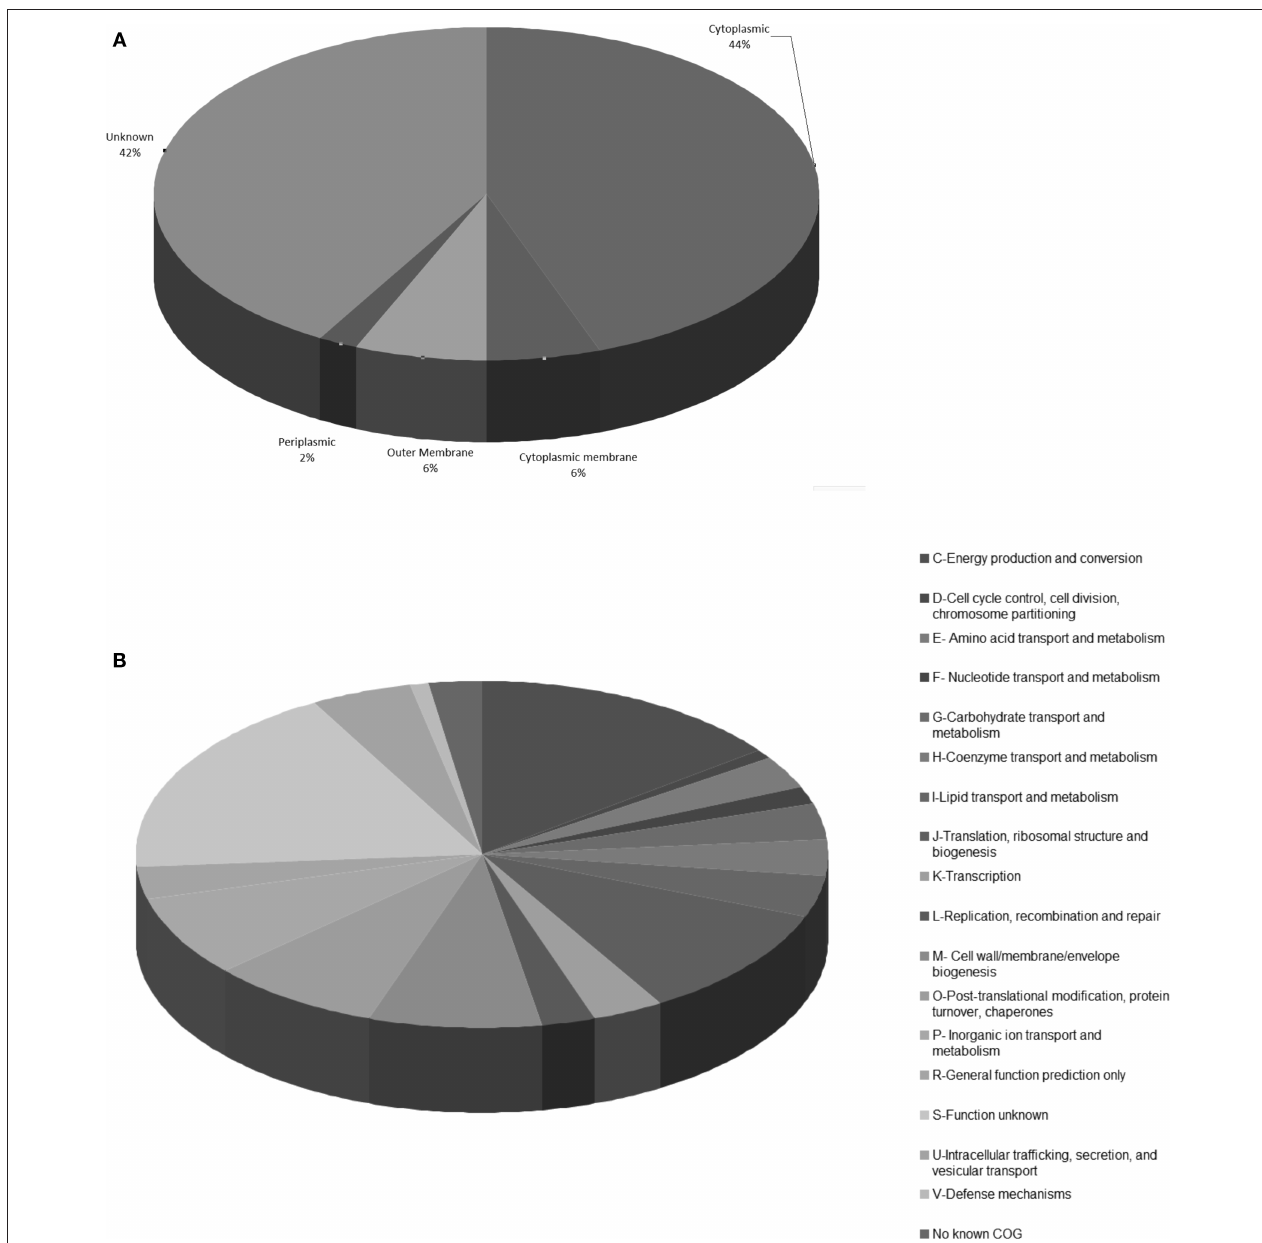
algorithm, for total reported immunoreactive proteins from Francisella immunoproteomics studies. Taken from the reported immunoreactive proteins listed in Table 3